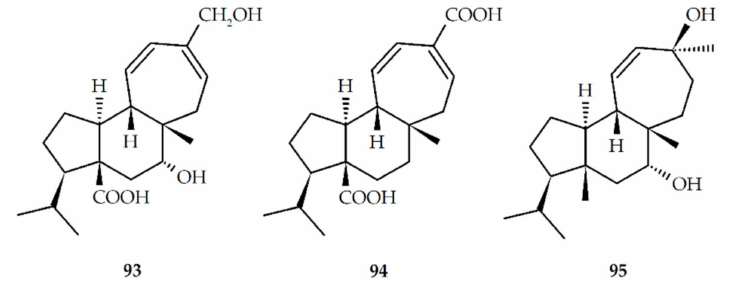
Figure 6. Biotransformed mulinane